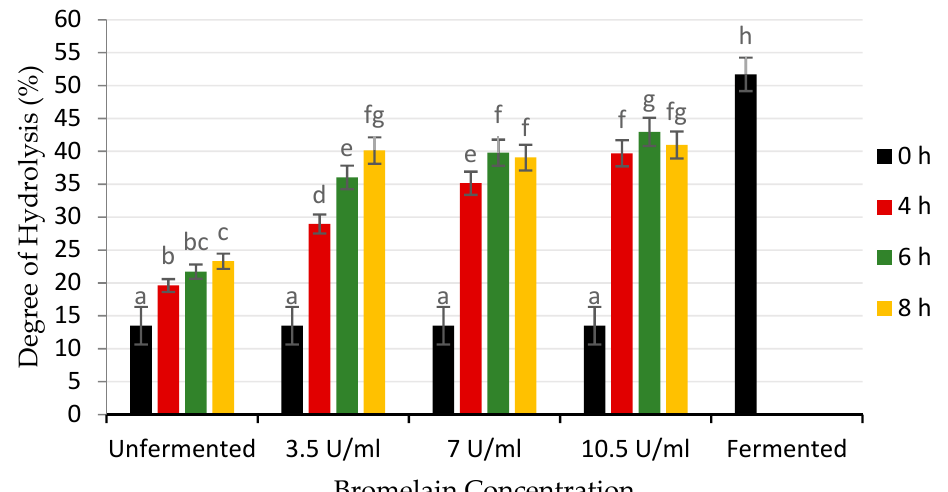
Figure 1. Degree of hydrolysis (%) of unfermented cocoa beans hydrolyzed by bromelain. Unfer- mented and fermented cocoa beans were used as a control. a–g Non-capital letters represent the statistical differences in the interaction of enzyme concentration and hydrolysis time ( p < 0.05).